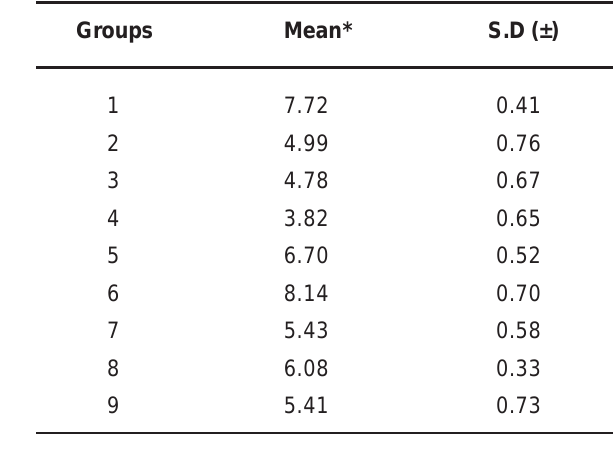
TABLE 2 - Shear Bond Strength (MPa) according to saliva contamination and re-etching time